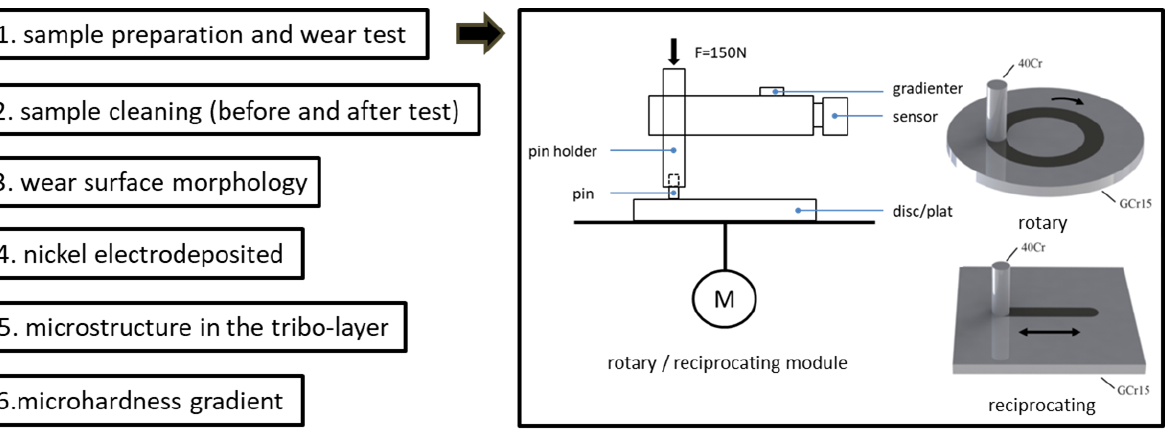
Figure 1. Schematic diagram of workflow of experimental tes